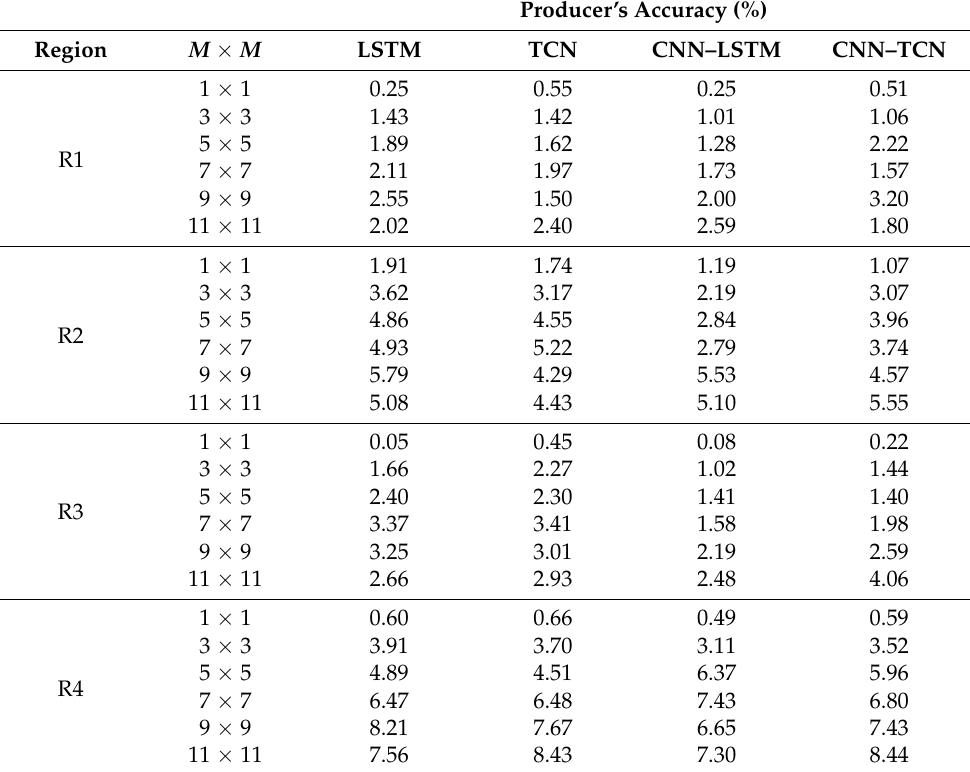
Table 5. Producer’s accuracy (PA) values obtained for (R1) the Regional District of Bulkley-Nechako, (R2) the Regional District of Central Kootenay, (R3) the Northern Rockies Regional Municipality, and (R4) the Cariboo Regional